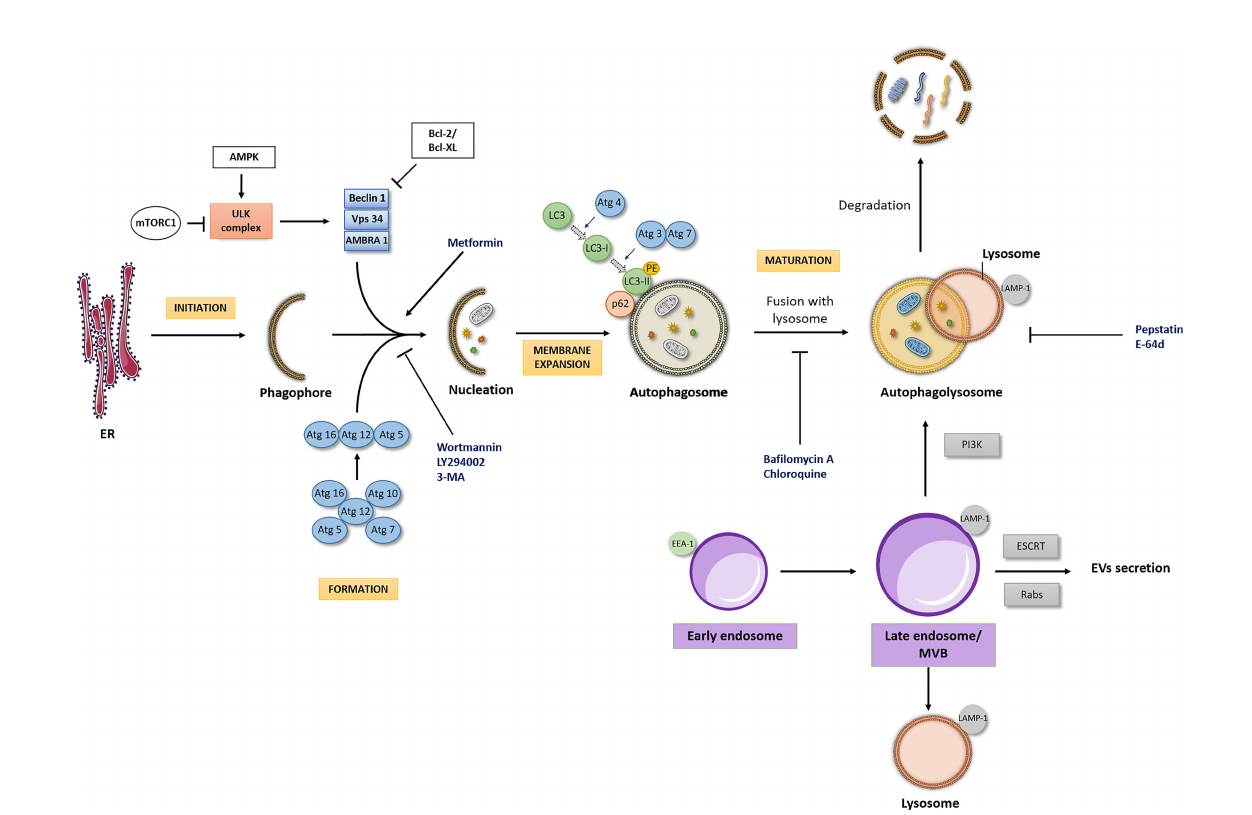
FIGURE 1 | Autophagic fl ux and interdependency of the intracellular pathways. Autophagic Flux: The four major stages of the autophagic pathway are shown in yellow boxes (initiation, formation, membrane expansion and maturation). Autophagy is a highly regulated process, focused on the lysosomal degradation of cellular components and/or recycling of cytosolic compounds. Initiation offormation of the phagophore begins when the ULK kinase complex is activated. A dedicated cohort of ATG proteins assemble into functional complexes, which are activated and recruited to membranes to initiate autophagy. The lipidation of ATG8/microtubule- associated protein 1 light chain 3 (LC3), promoting the conversion of LC3-I into LC3-II in membrane expansion stage and the degradation of p62/SQSTM1 (Sequestosome 1) in maturation stage are pivotal steps of autophagic process. Importantly, autophagic fl ux may be modulated by different drugs (here represented at blue font). PE, phosphatidylethanolamine; ER, Endoplasmic reticulum. Interdependency of the intracellular pathways: The endocytic pathway seems to be the scaffold for other intracellular pathways, such as the recycling, lysosomal and the autophagic pathway, with the endosome (here represented in purple boxes) being the main responsible for the interplay between these pathways. The interdependency of those intracellular pathways in fl uences a series of cellular processes and consequently its deregulation may cause different pathologies, including cancer. LAMP-1, Lysosome-associated membrane glycoprotein- marker of late endosome/lysosome; EEA1, Early Endosome Antigen 1- typical marker of early